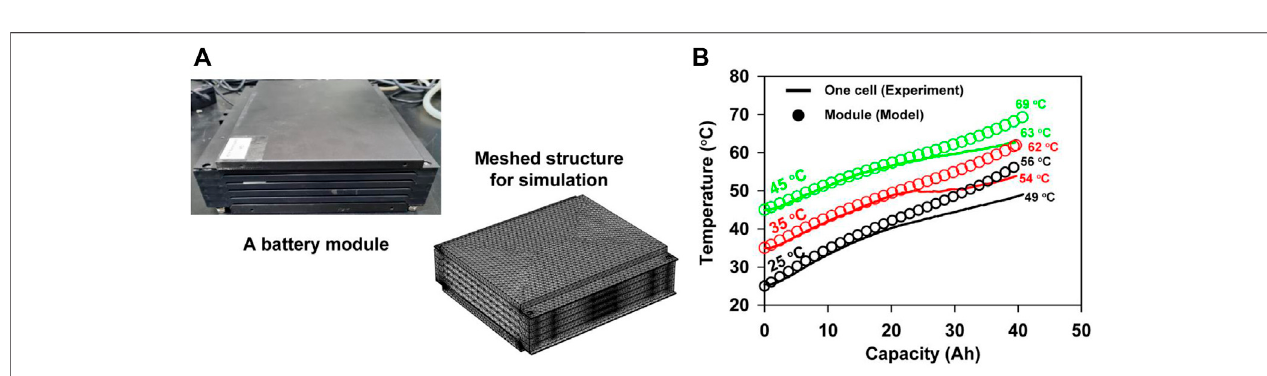
FIGURE 6 | (A) (Left) Photo of an actual battery module with fi ve cells and covers. (Right) The digital-twinned module structure with meshes. (B) Surface temperature changes of cells (measured) and modules (simulated) at external temperatures of 25 ° C, 35 ° C, and 45 ° C during 5C discharging.